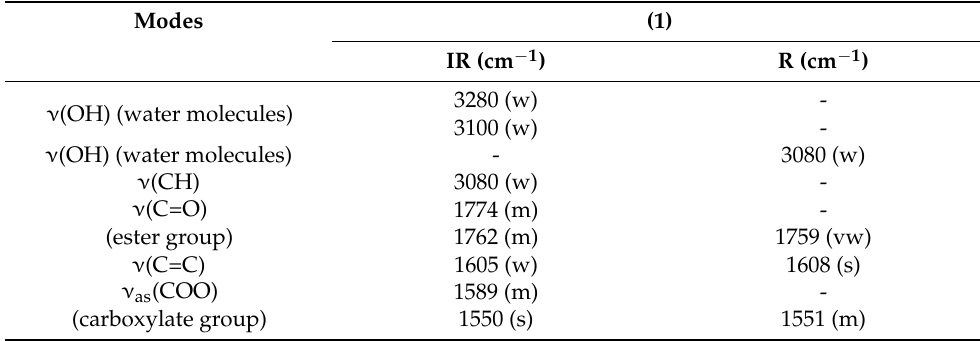
Figure 2. ( a ) Hirshfeld surface with projected all interactions shows prevailing blue color. The fingerprints for ( b ) H . . . H (83.5%), ( c ) O . . . H (11.7%), and ( d ) C . . . H (3.9%) are also given. Table 2. Positions of the selected bands registered in infrared (IR) and Raman spectra of ( 1 ) (very weak (vw), weak (w), medium (m), strong